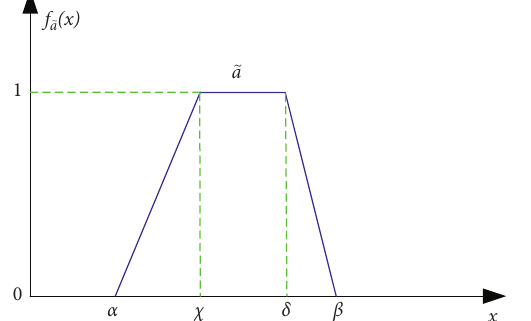
Figure 2: The membership function graph of triangular fuzzy